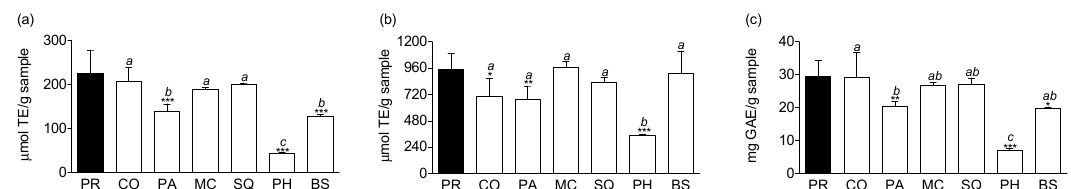
Figure 1. TPC and antioxidant activity and skin protective properties of cocoa samples. ( a ) FRAP-value; ( b ) ORAC-value; ( c ) Total phenolic content. BS: cocoa bean shell; CO: ordinary cocoa bean; KA: Kojic acid; MC: musty cocoa bean; OA: oleanolic acid; PA: pasilla; PH: cocoa pod husk; PR: premium cocoa bean; and SQ: second quality cocoa bean. Different letters indicate significant differences ( p < 0.05) between cocoa samples (Bonferroni’s multiple comparison test). For each cocoa sample, asterisk denotes significantly difference in comparison with the control PR (Dunnett’s multiple comparison test; * p < 0.05, ** p < 0.01 and *** p < 0.001).